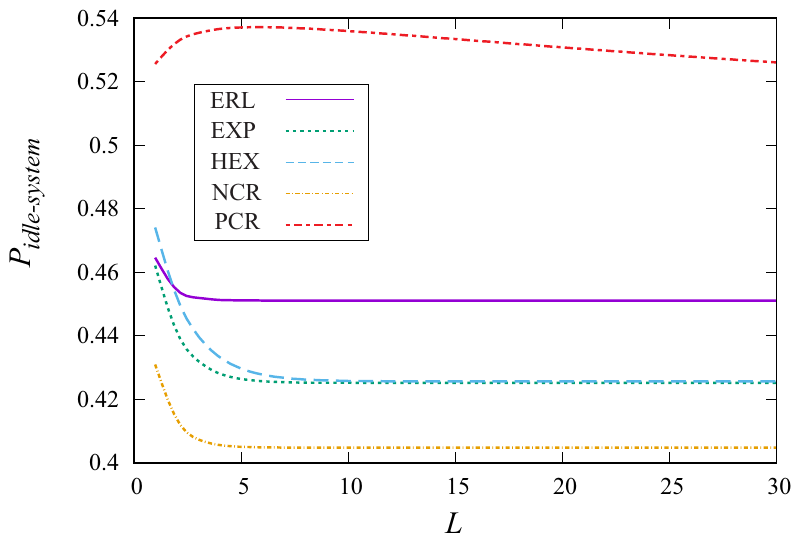
Figure 4. Dependence of the probability P idle − system that the system is idle at an arbitrary moment on the parameter L for different MAP s.